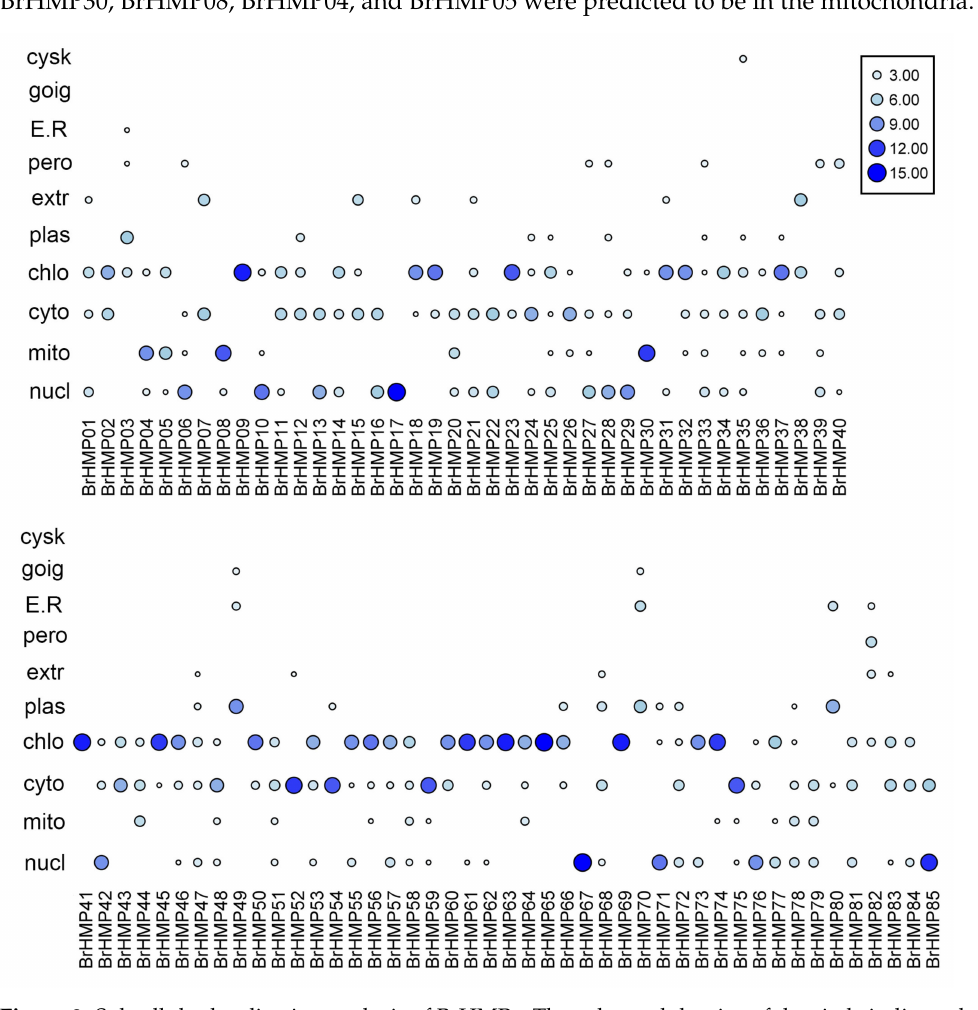
Figure 3. Subcellular localization analysis of BrHMPs. The color and the size of the circle indicate the reliability of the prediction. Nucl (nucleus), mito (mitochondria), cyto (cytoplasm), chlo (chloroplasts), plas (plasmids), extr (extracellular), pero (peroxisome), E.R (endoplasmic reticulum), goig (golgi apparatus), cysk